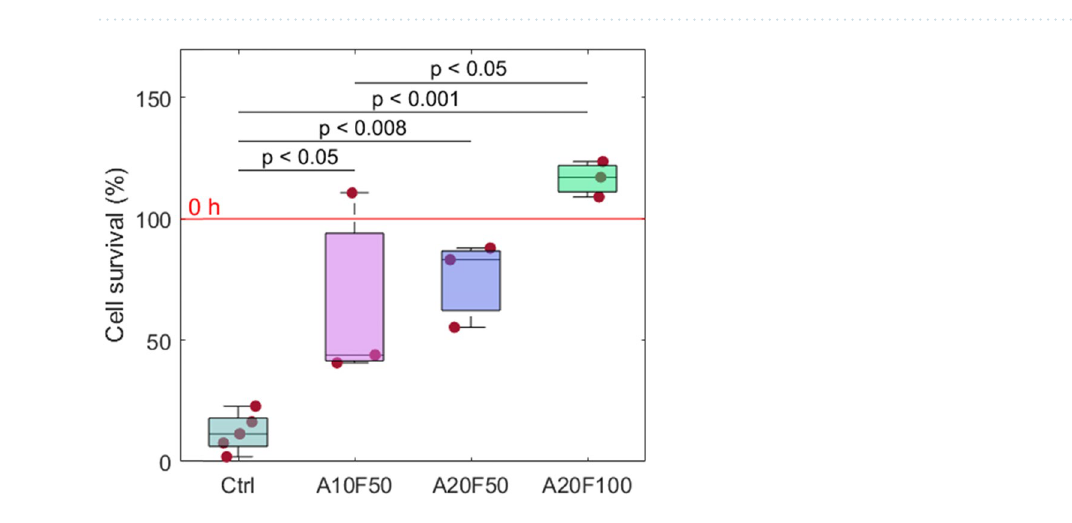
Figure 1. MC3T3-E1 preosteoblast morphology (scanning electron microscopy). ( A – C ) MC3T3-E1 cells precultured cells on Ti6Al4V for 16 h prior to electrical stimulation. ( D – L ) MC3T3-E1 cells after 72 h of pulsed electrical stimulation under different combinations of amplitude and frequency; ( D – F ) A10F50, ( G – I ) A20F50, and ( J – L ) A20F100.